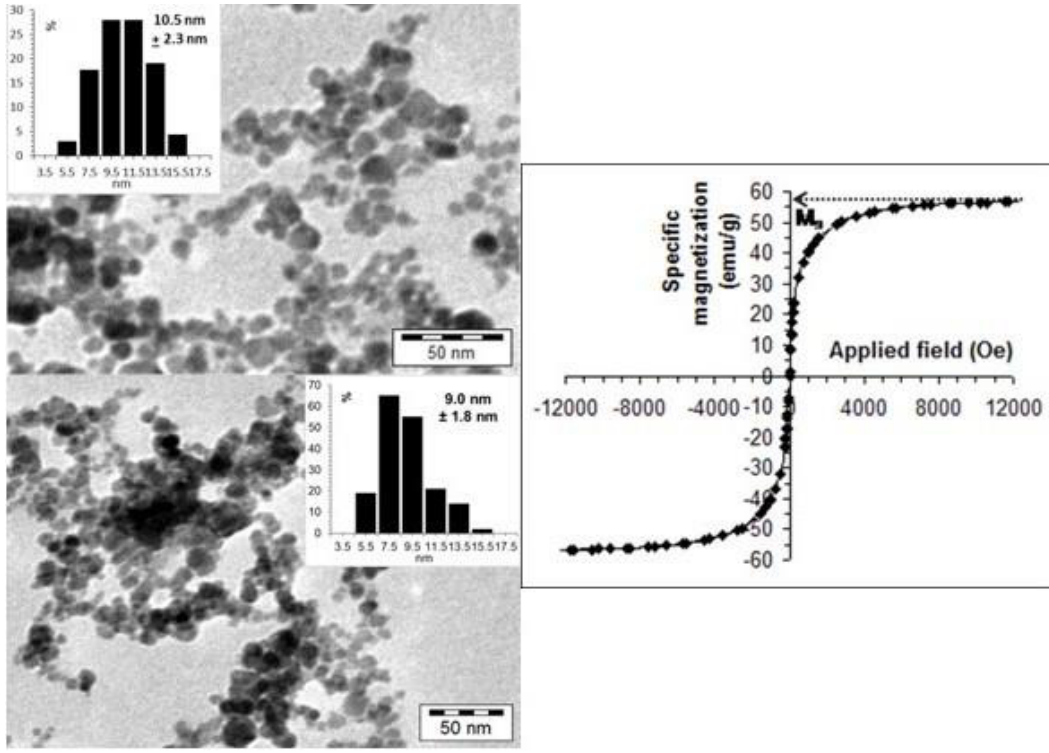
Figure 2. ( a ) TEM picture and particle size distribution of CSA@MNP nanoparticles at pH ~6.3 (top) and that of naked MNPs (bottom); ( b ) specific magnetization curve measured in the dispersion CSA@MNPs at room temperature (10 g / L in water at pH ~6.3). (The M s is assigned only for illustration.).